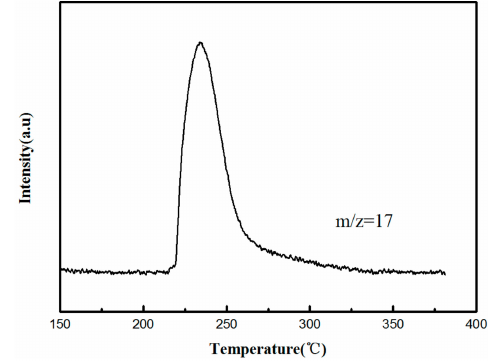
Figure 5. TPD-MS spectra of desorption of the crystals.